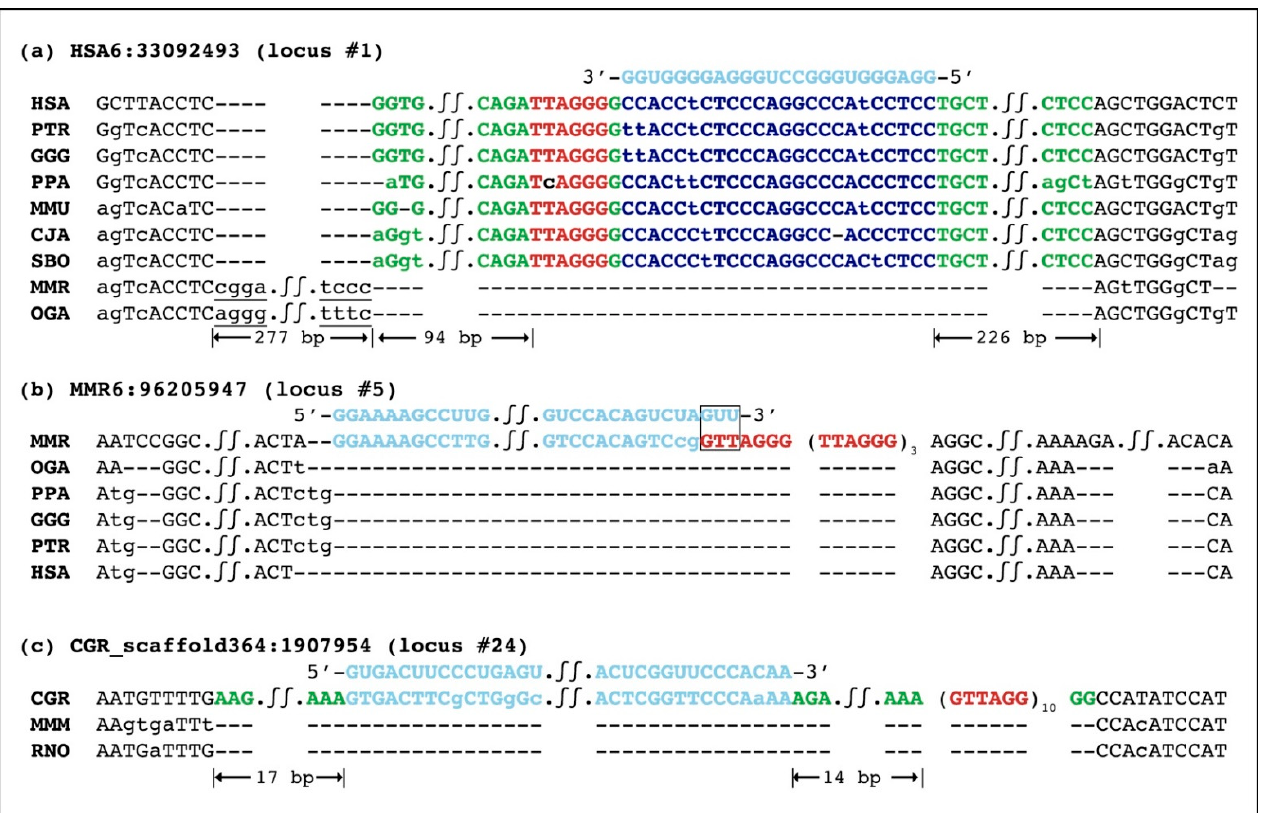
Figure 1. Examples of sequence alignments of orthologous TERC-ITS loci. For each locus, the top row shows the sequence of the telomerase RNA domain (light blue) homologous to the inserted TERC-like fragment. Species names are indicated on the left. Telomeric repeats are indicated in red. The TERC-like sequences homologous to a region of the telomerase RNA are indicated in light blue and the sequence complementary to a region of the telomerase RNA is in dark blue. Modifications of the insertion sites are shown: underlined nucleotides indicate deletions and green nucleotides indicate random sequence insertions. Nucleotides at the 3 ′ end of the TERC-like sequence in frame with the inserted telomeric repeats are boxed. ( a ) Simiiformes-specific TERC-ITS locus initially identified on human chromosome HSA6:33092493. The orthologous loci from mouse lemur and Northern galago are empty. ( b ) TERC-ITS at locus MMR6:96205947 from mouse lemur. The TERC-ITS is present only in the mouse lemur lineage, whereas in other primates the orthologous locus is empty. ( c ) TERC-ITS at locus CGR_scaffold364:1907954 specific to the Chinese hamster lineage. Orthologous loci from mouse and rat are empty.